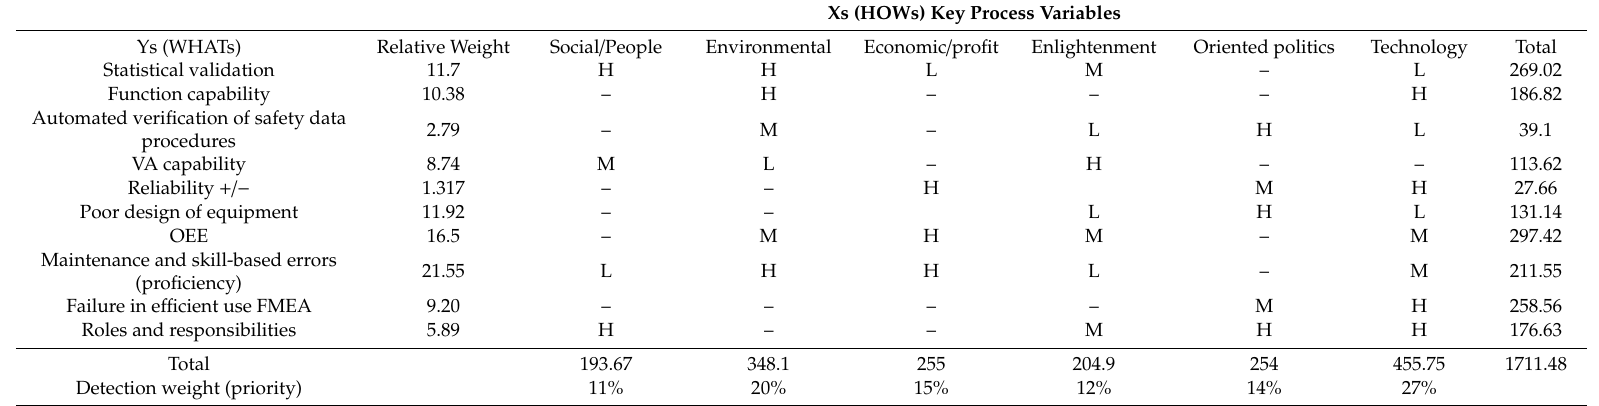
Table 8. Safety Function Deployment (Step